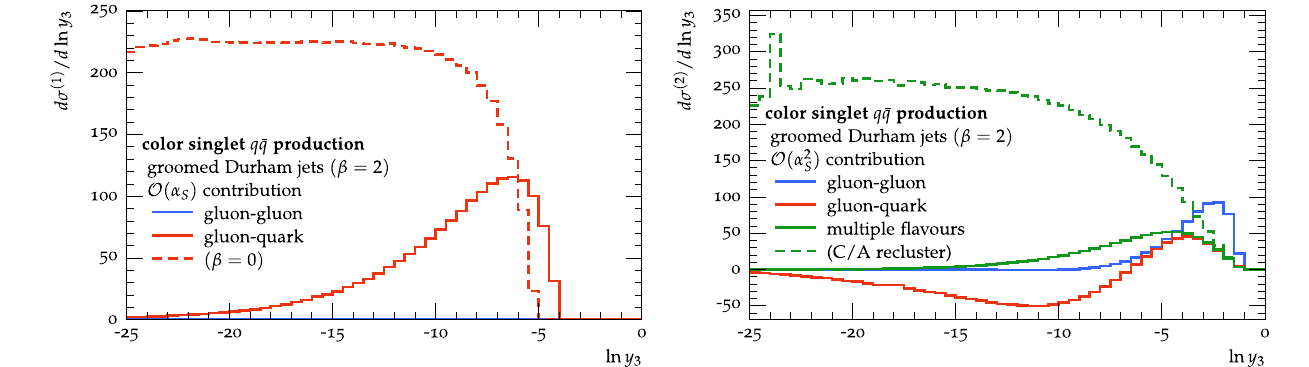
reclustered with J ADE (solid). Two IRC-unsafe flavour definitions are also shown dashed: on left, jet flavour with β = 0 SD/mMDT grooming and on right, β = 2 SD grooming but with C/A